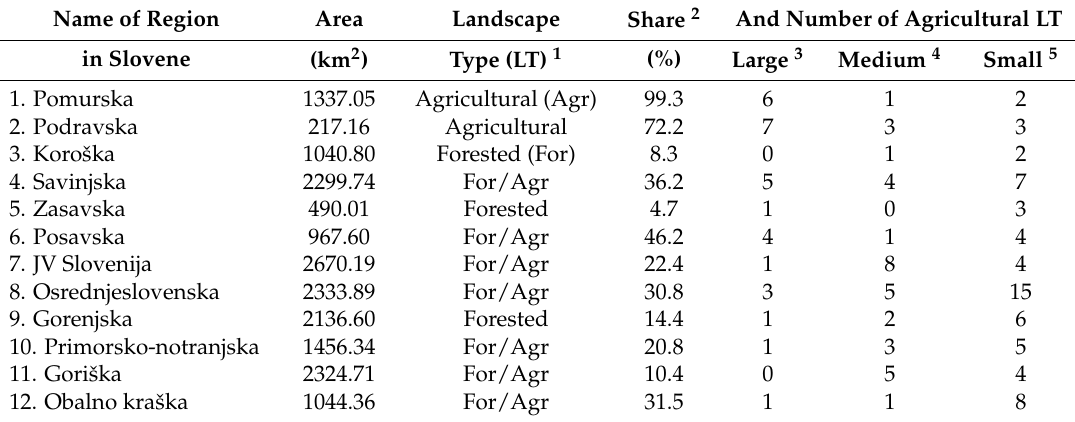
Table 1. Estimations of landscape structure in the statistical regions of